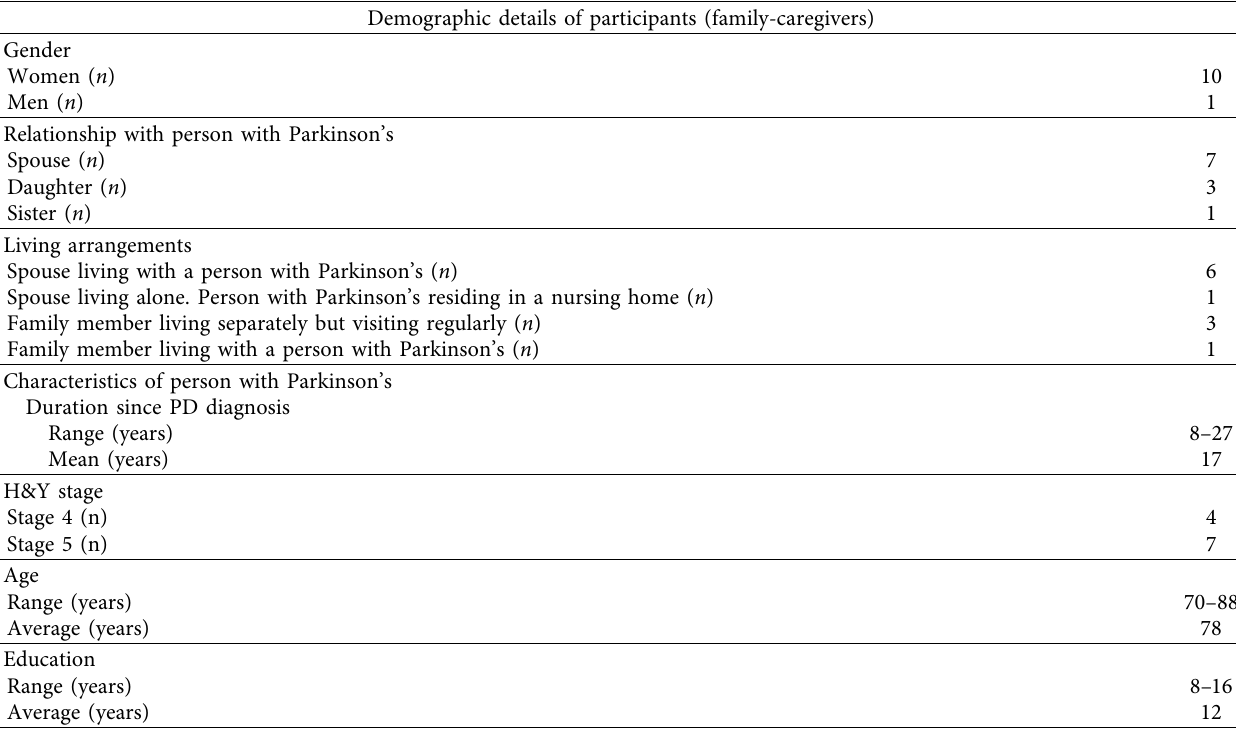
Table 1: Participant characteristics (family-caregivers), n � 11, and characteristics of the persons with Parkinson’s they cared